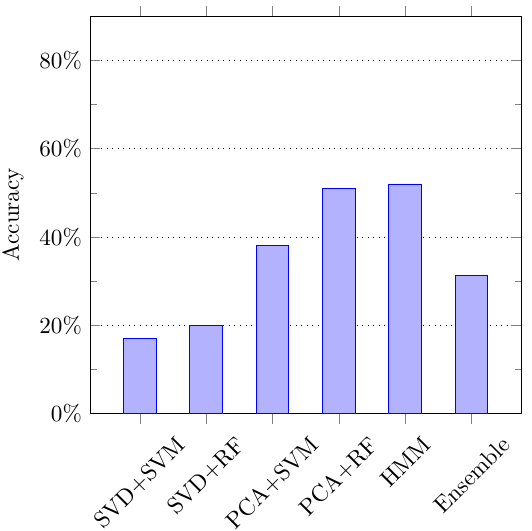
Figure 10. The composite activity recognition accuracies using ensemble